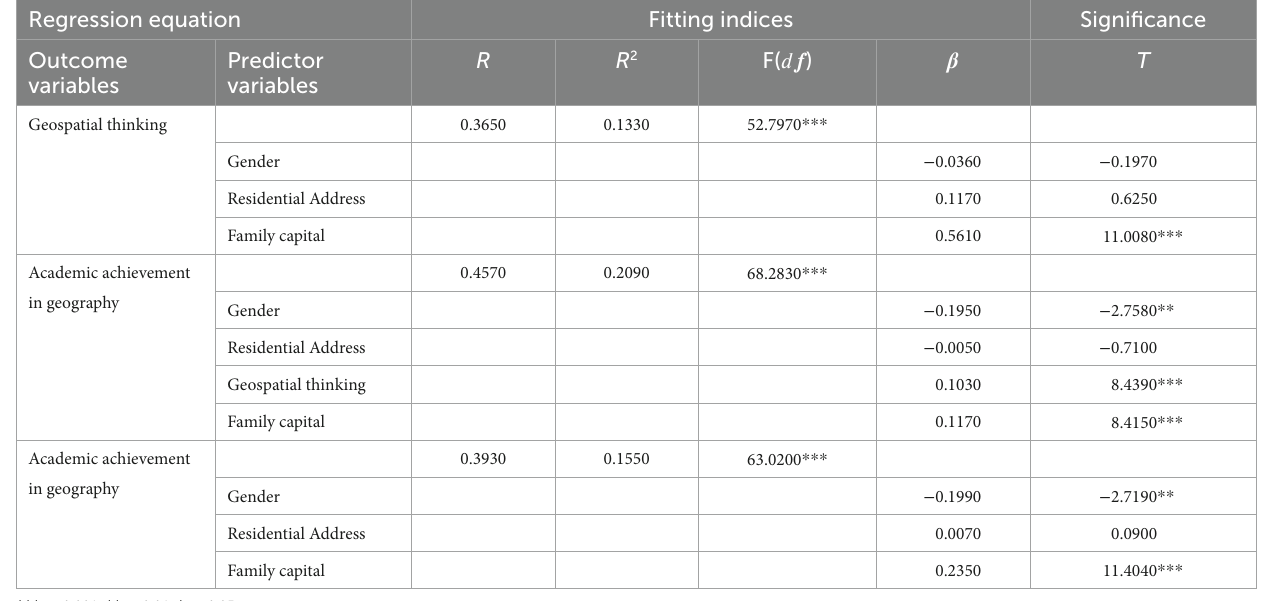
TABLE 3 Results of mediation analysis for the observed variables. Regression equation